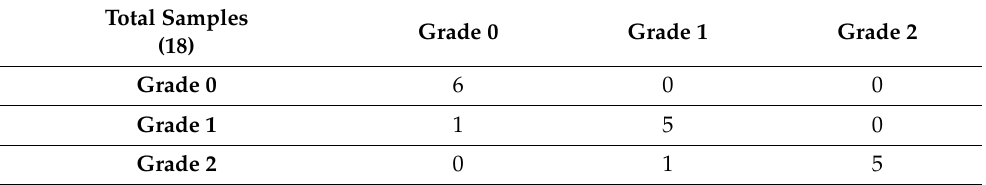
Table 6. Testing confusion matrix of ADAM empowered with AlexNet (non-augmented test